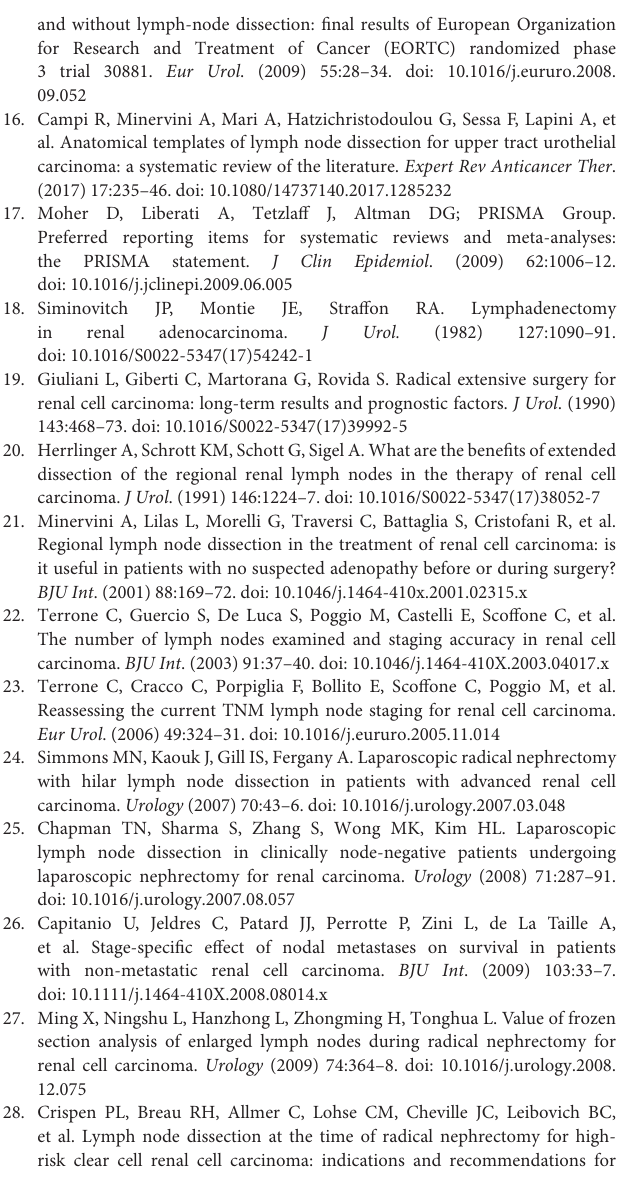
Supplementary Figure 1 | Flow-chart showing the literature search and systematic review process according to the Preferred Reporting Items for Systematic Reviews and Meta-analyses (PRISMA) statement recommendations. Supplementary Table 1 | Risk of bias assessment among studies included in the review according to the Newcastle-Ottawa-Scale (NOS) for non-randomized studies and to the Cochrane risk of bias assessment tool for randomized trials. / = not applicable; Un = unclear. The overall quality of evidence was assessed according to Grading of Recommendations Assessment, Development, and Evaluation (GRADE) recommendations (53)